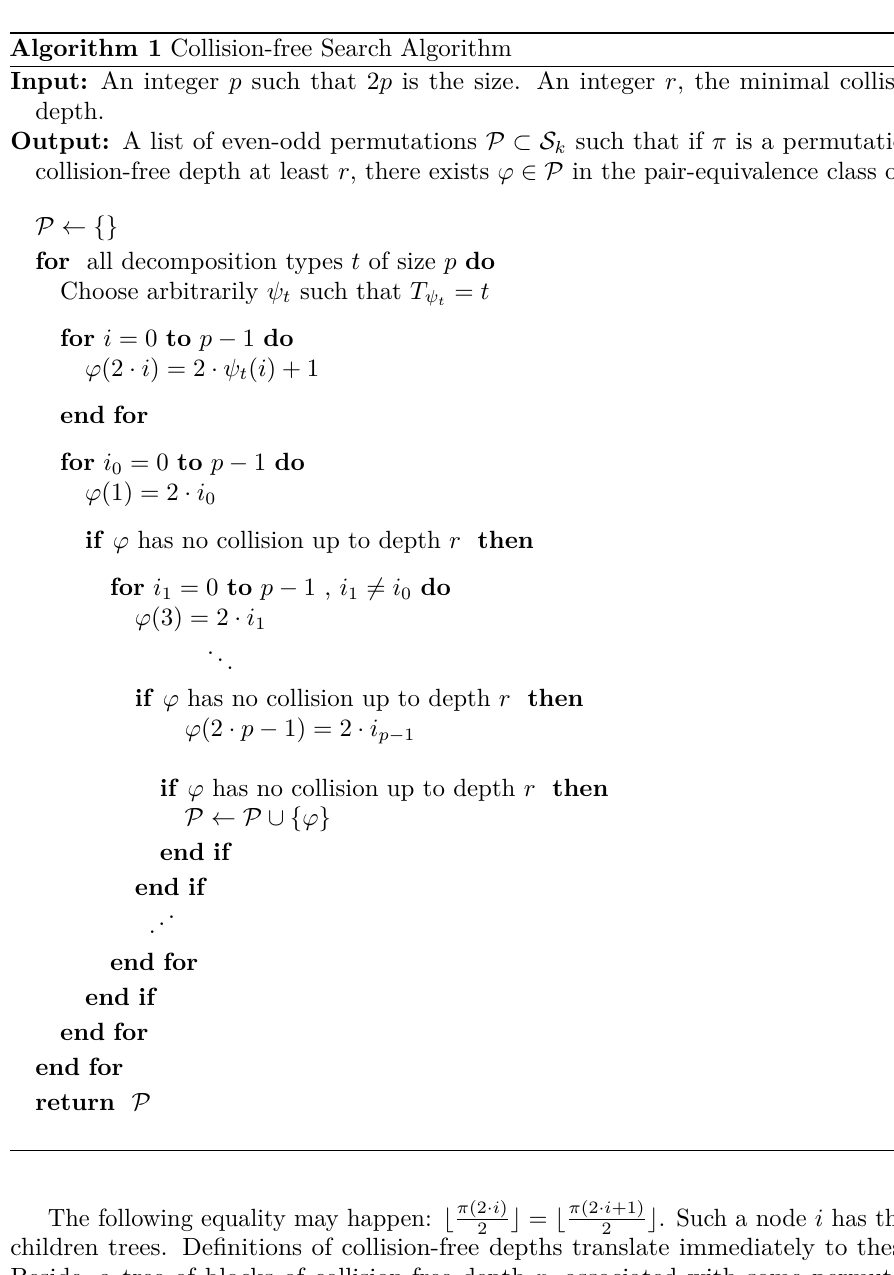
Algorithm 1 Collision-free Search